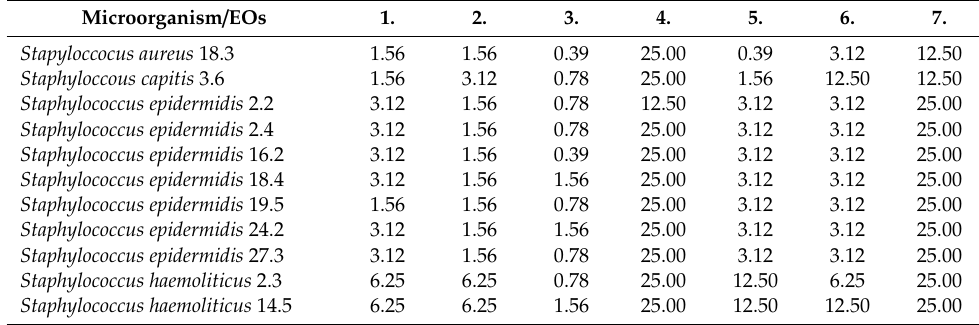
Table 5. Antimicrobial activity of EO detected with minimal inhibitory concentration in µ L / mL. Microorganism / EOs 1. Stapyloccocus aureus